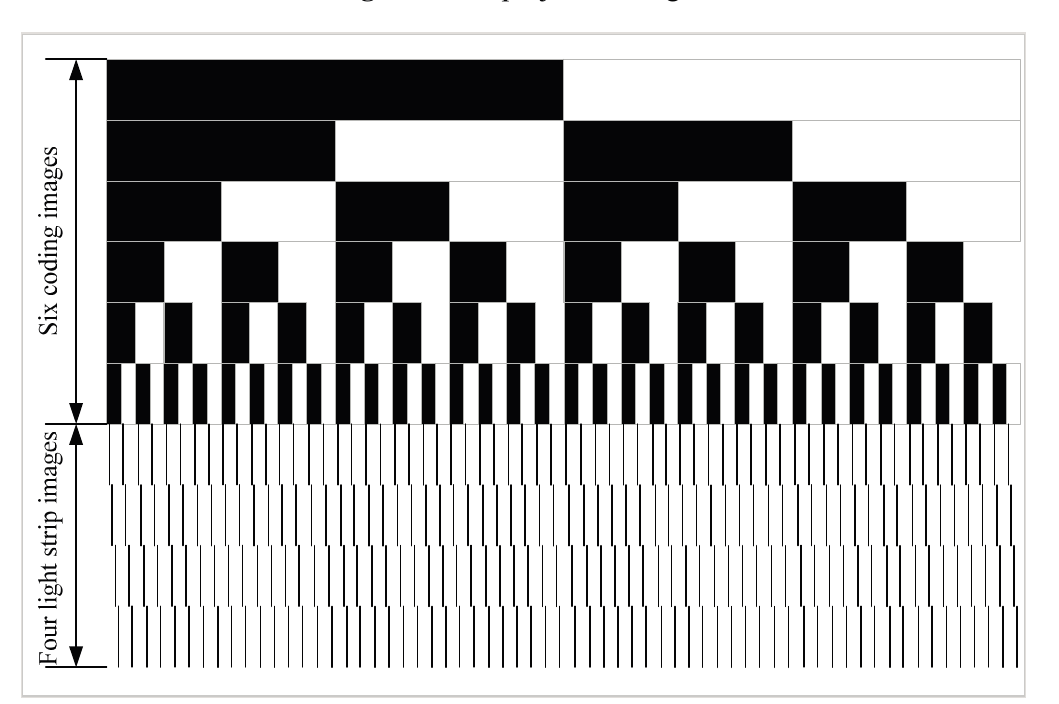
Figure 5. Line distribution diagram of all projected